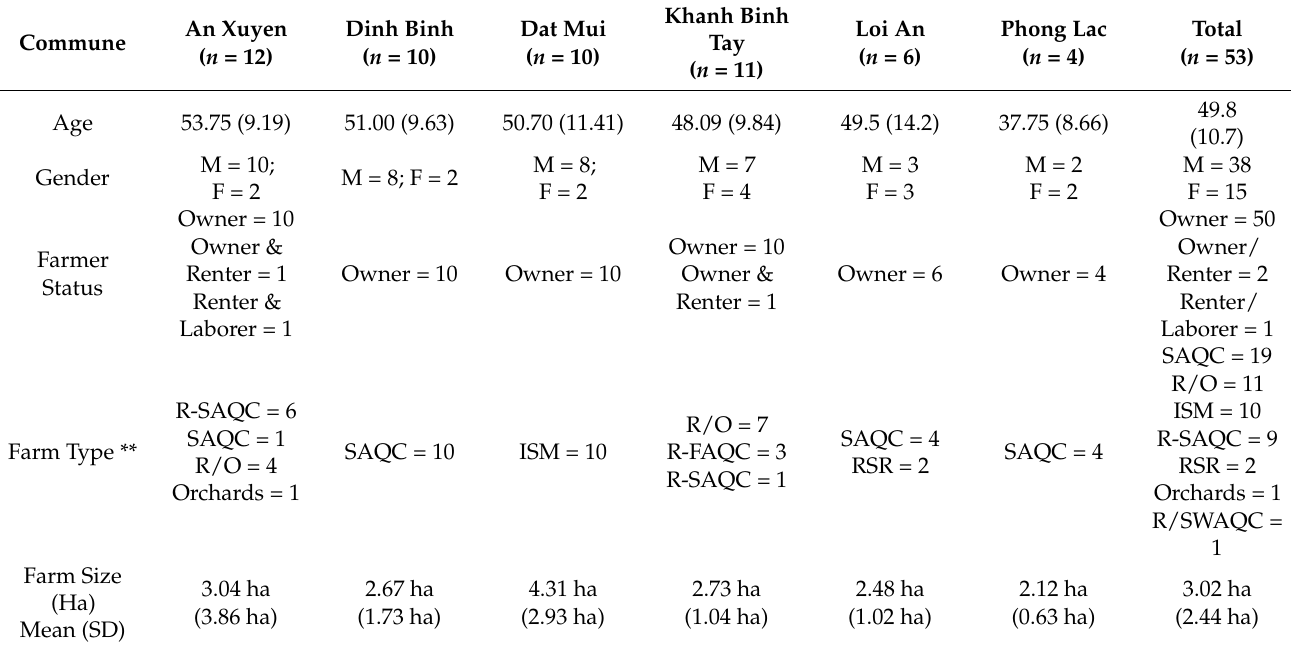
Table 3. Sample characteristics by commune.